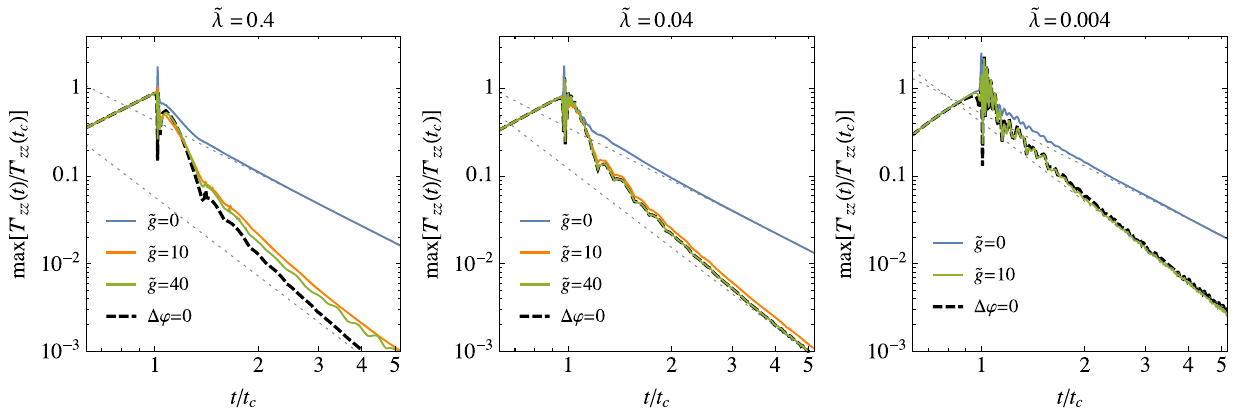
Fig. 2 Evolution of the GW source in collision of two bubbles averaged over simulations with different initial complex phase differences. The collision happens at t = t c . Solid curves correspond to different values of ˜ g and the dashed curve to (cid:10)ϕ = 0. The dotted lines show ∝ t − 2 and ∝ t − 3